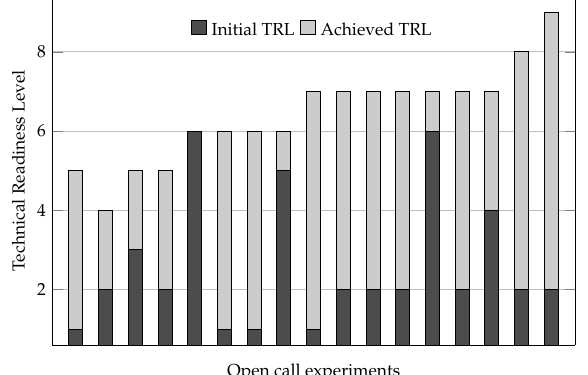
Figure 9. Technical readiness evolution of the experiments during the OrganiCity second open call according to experimenters’ feedback. Concrete experiments’ names are